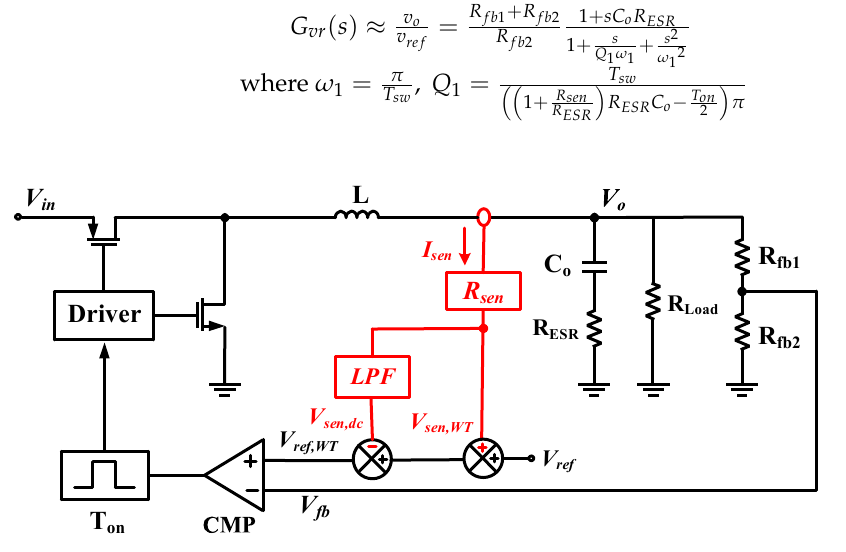
Figure 9. Linear model of the buck converter with WTR control.